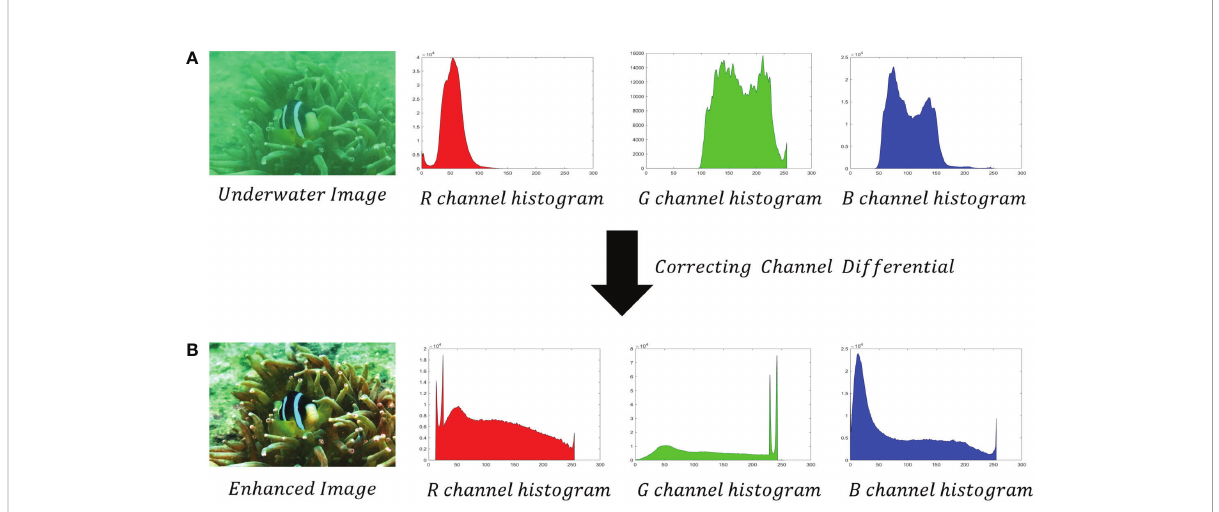
FIGURE 5 (A) image is the original underwater image and it's histogram of the RGB (red, green, blue) channels. (B) image is the enhanced image and it's histogram of the RGB (red, green, blue) channels.